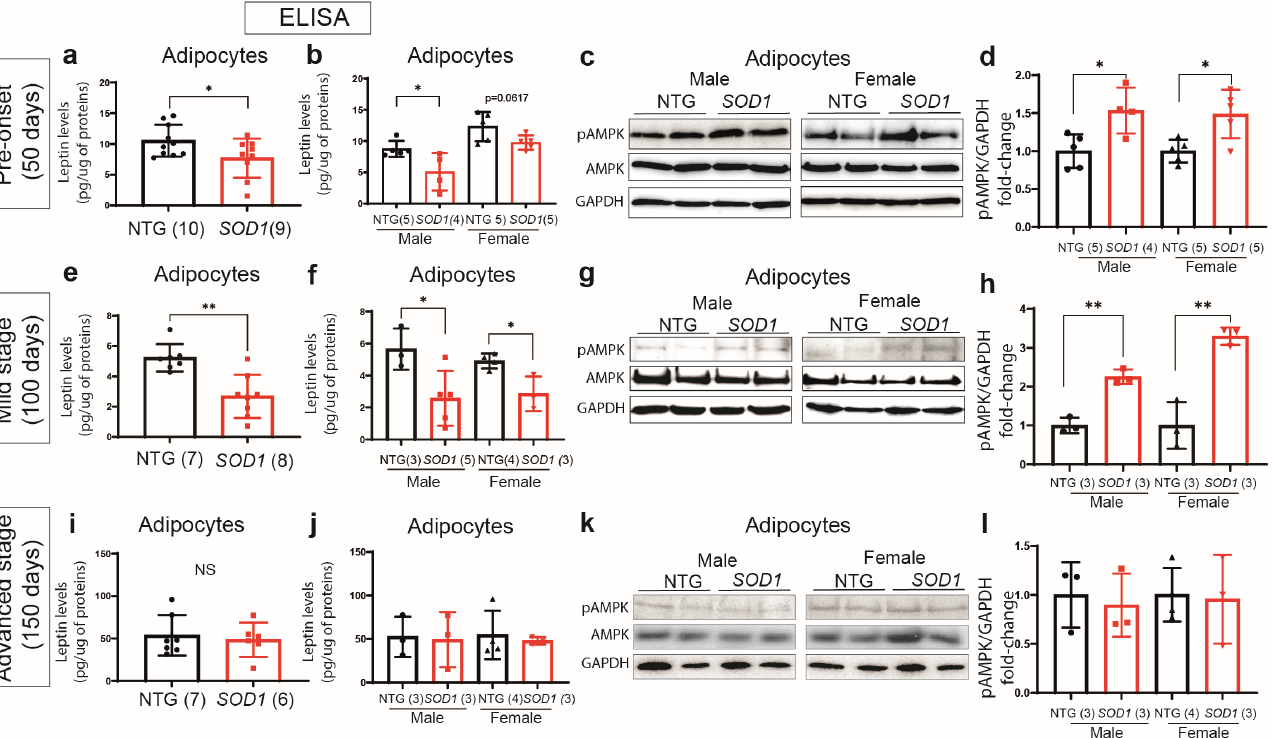
Figure 5. Leptin production by SOD1 G93A mice adipocytes. Total proteins from SOD1 G93A mice fat tissue were extracted with RIPA buffer as detailed in material and methods. ( a ) Levels of leptin